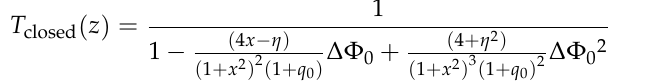
Figure 8. Raman spectra of the laboratory slide, activated carbon (AC), and the fabricated CNPs.